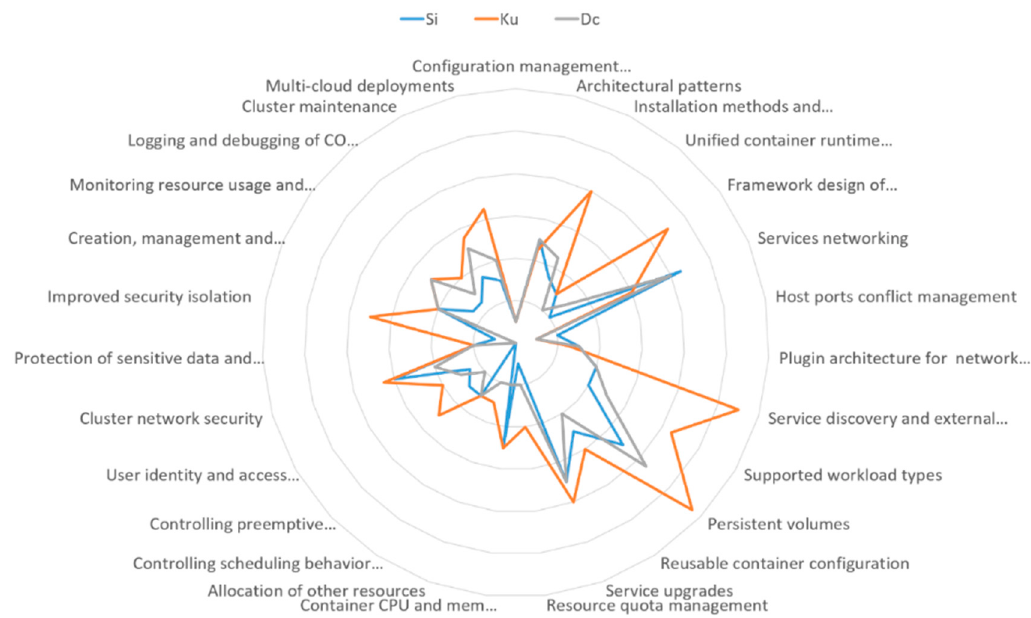
Figure 10. Radar chart of Docker Swarm integrated mode, Kubernetes and DC/OS for common + unique features.